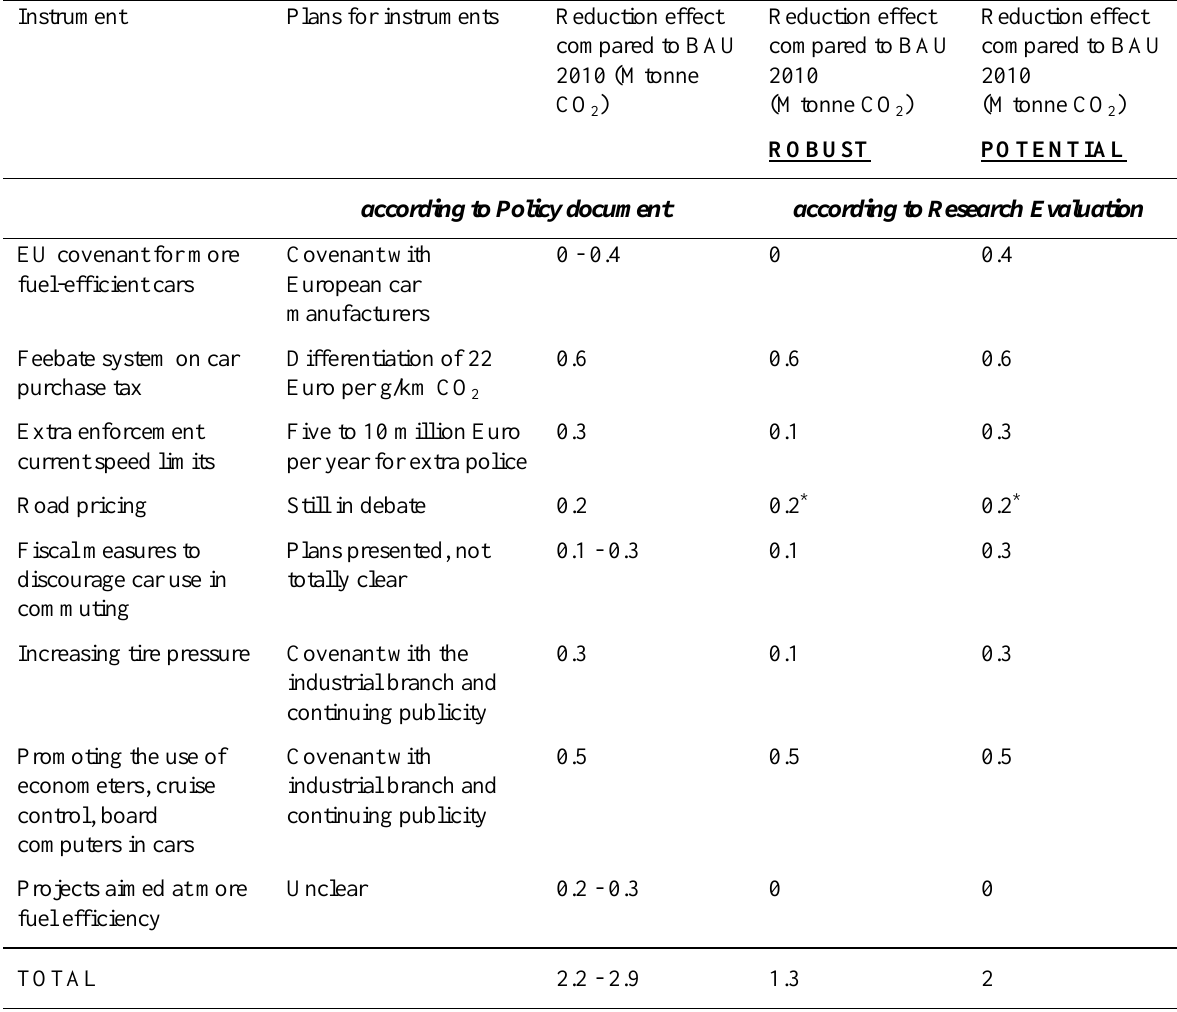
Table 4 Estimated GHG emission reduction in the Policy document and the